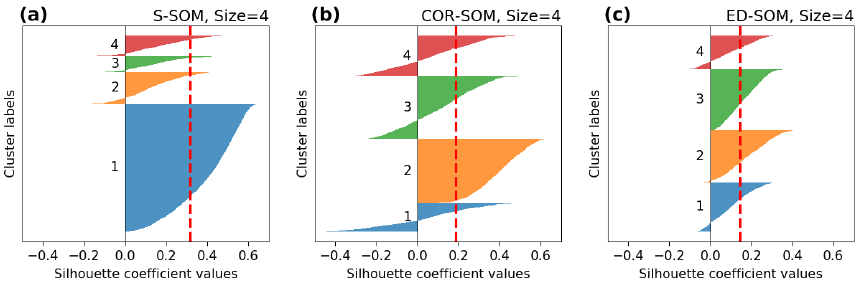
Figure 5. Silhouette plots for S-, COR-, and ED-SOM clustering for winter months (DJF). Note that these are results from simulations with the SOM-node size of 4. The vertical dashed red lines in each plot indicate the silhouette